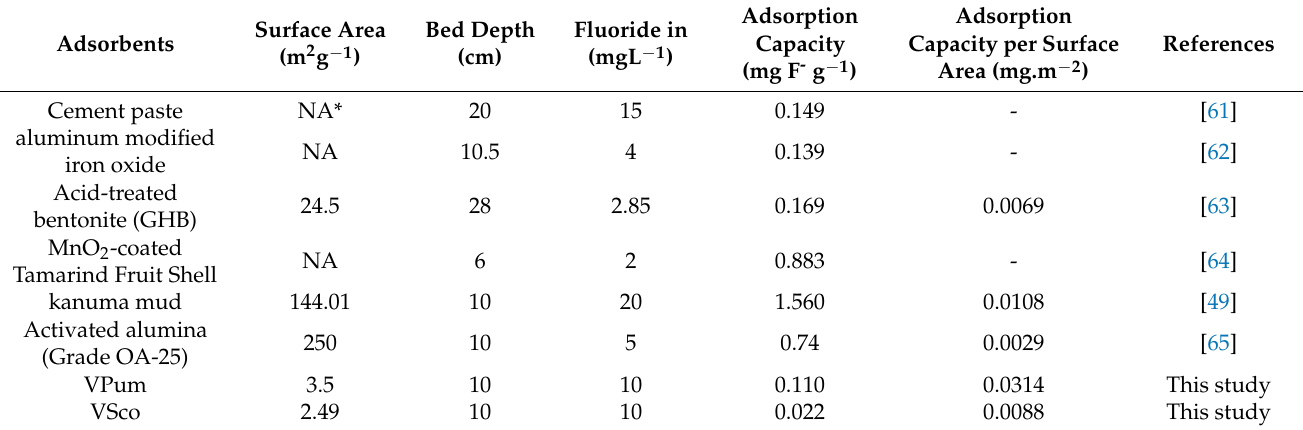
Table 5. Comparison of other adsorbents with VPum and